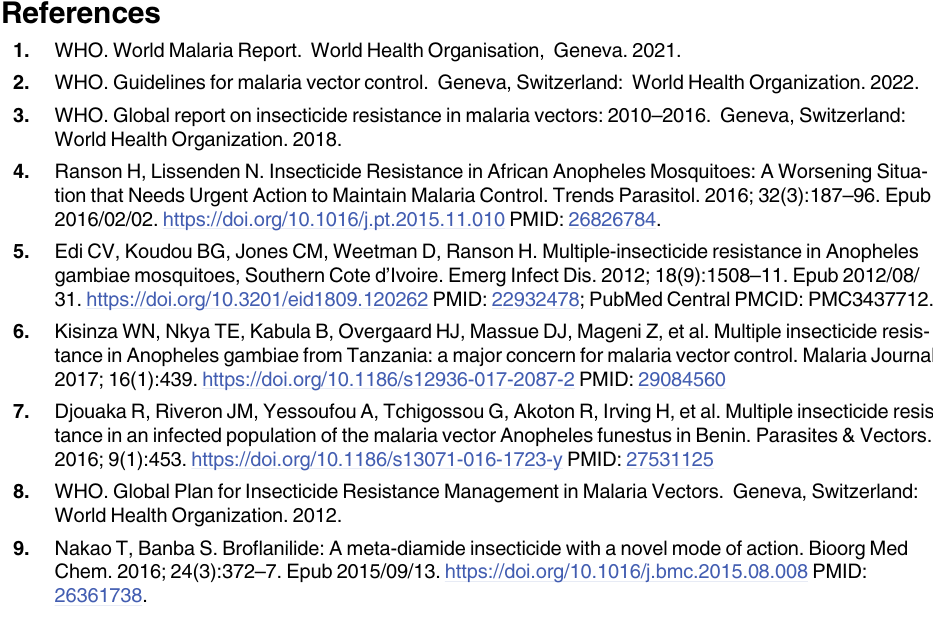
S1 Table. Detailed bottle bioassay data with wild pyrethroid-resistant Anopheles gambiae sl from villages in southern